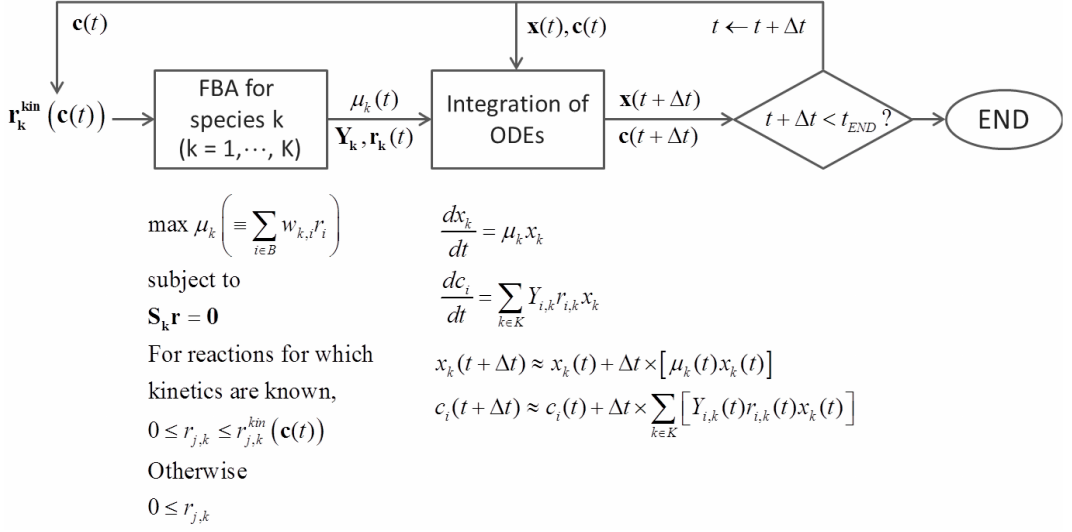
Figure 14. Implementation of the Dynamic Multispecies Metabolic Modeling